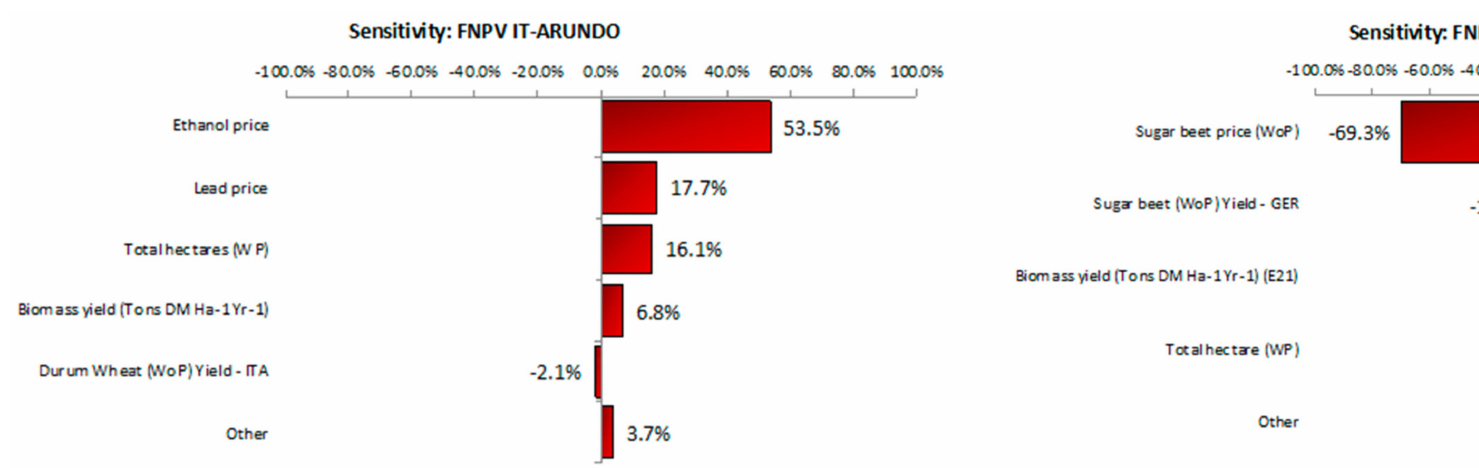
Figure A1. Probability distribution of FNPV ( upper ) and ENPV ( lower ) resulting from Monte Carlo simulation.